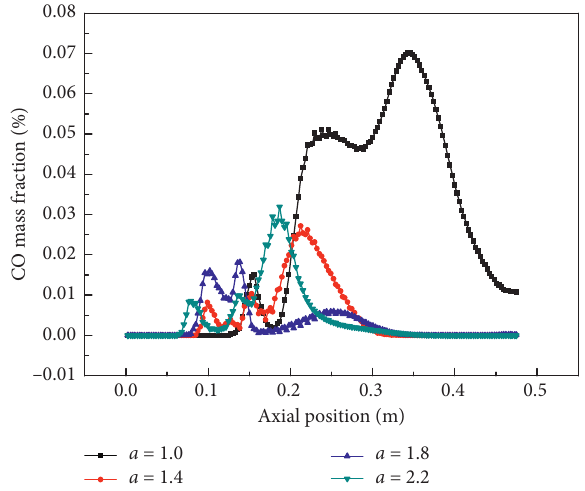
Figure 9: CO concentration distribution along the longitudinal centerline of the burner under different excess air